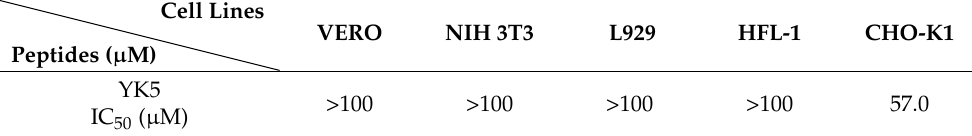
Figure 4. Micro-broth dilution tests and MIC values of YK5. ( □ ) Listeria innocua , ( ○ ) Staphylococcus aureus , ( △ ) Pseudomonas aeruginosa , (+) Salmonella typhimurium , and (*) Escherichia coli . Table 2. Cytotoxicity test of YK5 against various mammalian cell lines.